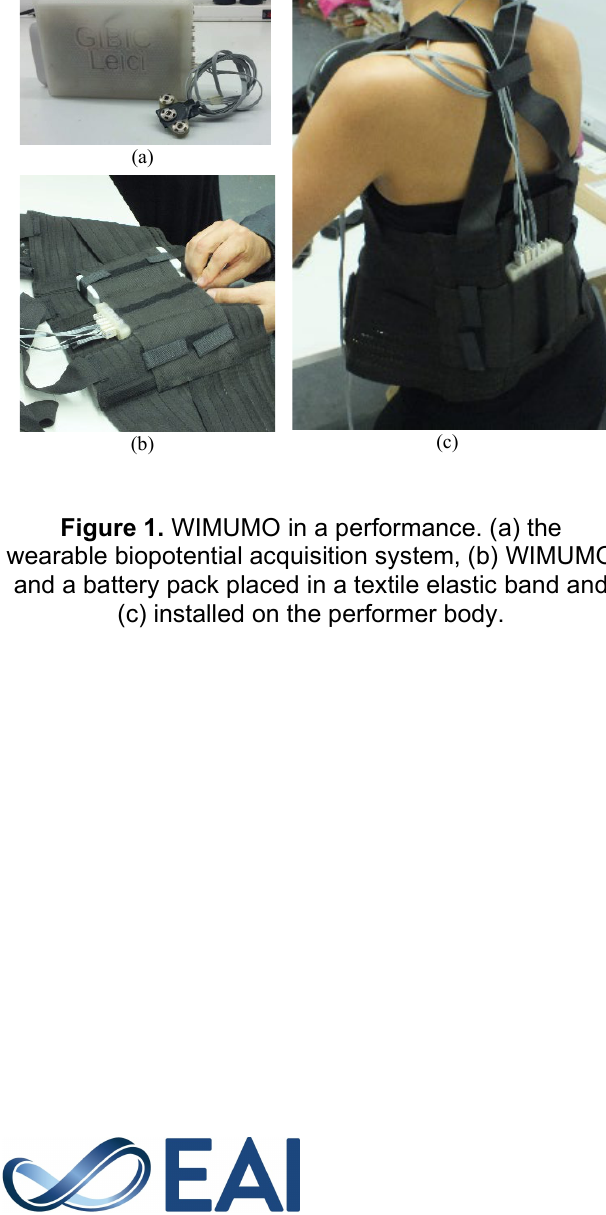
Figure 2. Photos of the artist in two different performances wearing